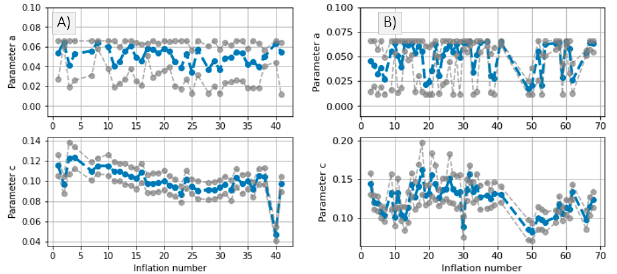
Figure 11. Inference results of the parameters a and c per inflation; ( A ) Patient 1 data and ( B ) Pa- tient 2 data. Blue represents the central tendency of the posterior distribution, gray represents the 95% HDI.